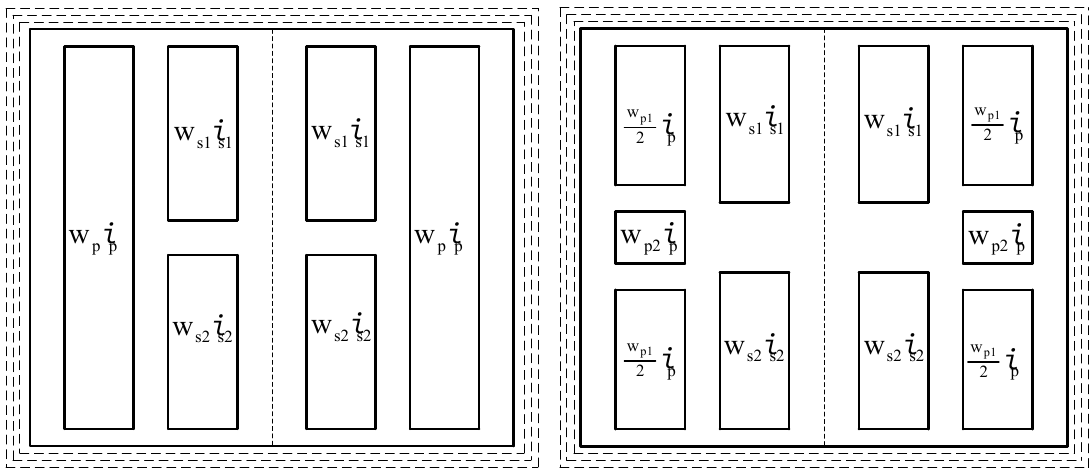
Figure 2. Winding’s location in rectifier transformers ( a ) 3/6 phase transformers ( b ) 3/12 phase